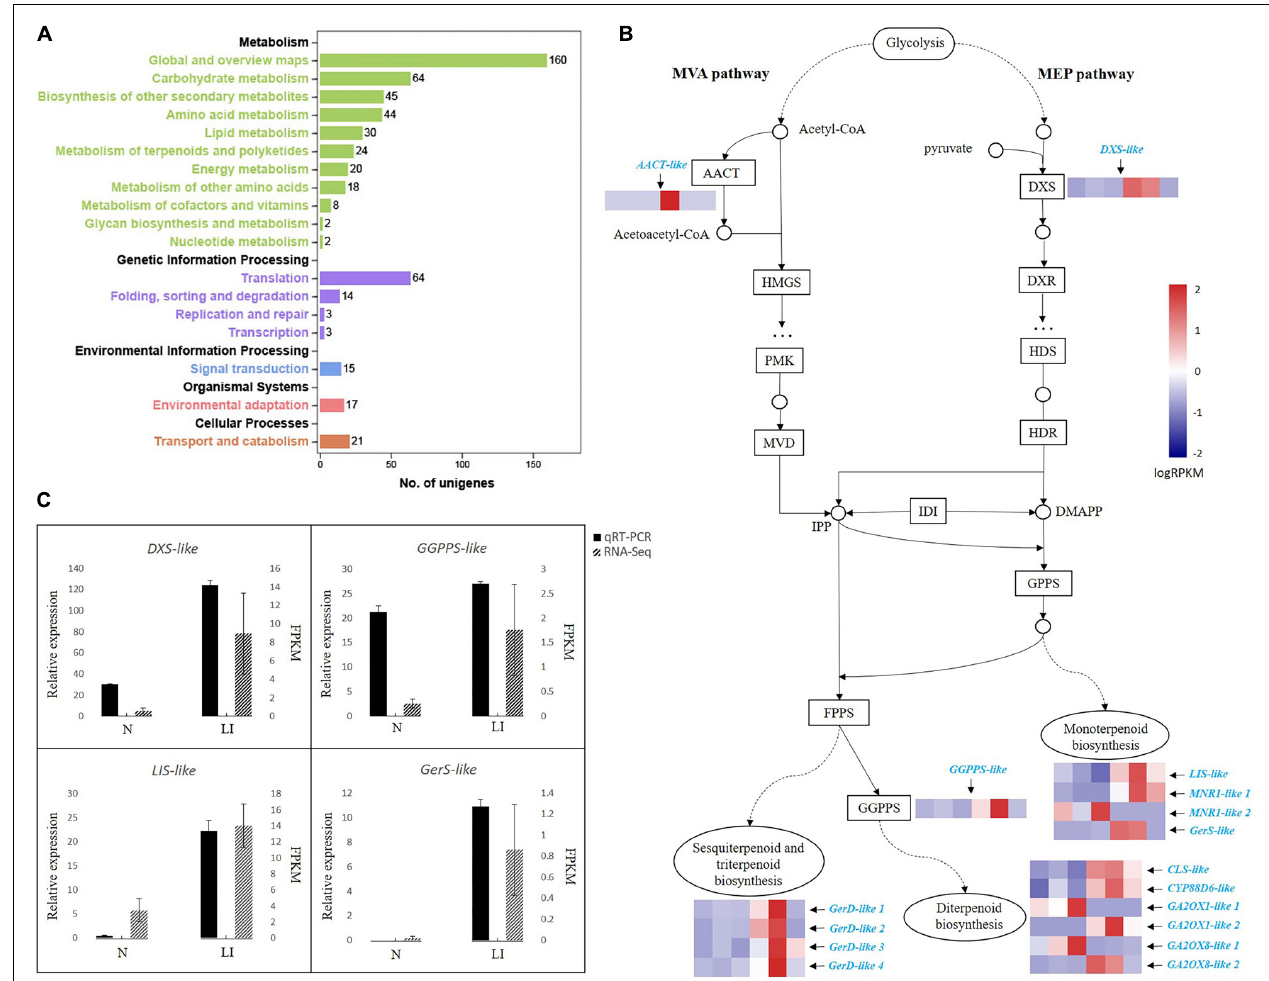
FIGURE 2 | Transcriptional cascade of DEGs in terpenoid backbone biosynthesis in linalool-type C. camphora . (A) KEGG pathway annotations of DEGs. The x- axis indicates the number of unigenes annotated in each corresponding pathway. The five categories of KEGG pathways are divided and color-coded. (B) DEGs in terpenoid backbone biosynthesis. The transcriptional cascade of terpenoid backbone biosynthesis is shown in the form of protein-coding enzymes or nodes annotated by KEGG pathway analysis. Enzyme expression patterns are indicated with logRPKM values, and DEGs are in azure. The left three and right three columns represent low oil content type (N) and linalool type (LI), respectively. AACT, acetyl-CoA C-acetyltransferase; DXS, 1-deoxy- D -xylulose-5-phosphate synthase; HMGS, hydroxymethylglutaryl-CoA synthase; PMK, phosphomevalonate kinase; MVD, mevalonate diphosphate decarboxylase; DXR, 1-deoxy-d-xylulose-5-phosphate reductoisomerase; HDS, hydroxymethylbutenyl 4-diphosphate synthase; HDR, (E)-4-hydroxy-3-methyl-but-2-enyl diphosphate reductase; IDI, isopentenyl-diphosphate delta-isomerase; GPPS, geranyl diphosphate synthase; FPPS, farnesyl pyrophosphate synthase; GGPPS, geranylgeranyl pyrophosphate synthase; LIS, linalool synthase; MNR1, ( + )-neomenthol dehydrogenase-like isoform; GerS, geraniol synthase; GerD, ( − )-germacrene D synthase; CLS, ent-copalyl diphosphate synthase; CYP88D6, cytochrome P450 88D6; GA2OX, Gibberellin 2-beta-dioxygenase. (C) qRT-PCR validation of RNA-Seq data. The black bars represent relative gene expression determined by qRT-PCR (left y -axis) and the dotted gray bars represent gene expression levels detected by RNA-Seq (right y- axis). Standard errors of the three technical replicates of each sample of the qRT-PCR analysis and three biological replicates in the two experimental groups of the RNA-Seq analysis are indicated by error